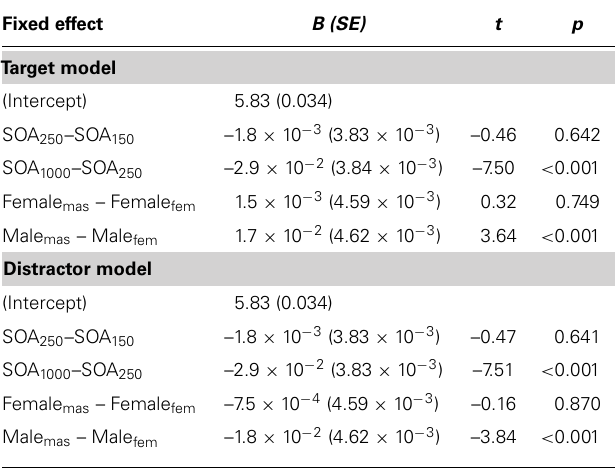
Table 7 | Fixed effect estimates for SOA and GI parameters in the final LMMs of log-transformed SRTs in Experiment